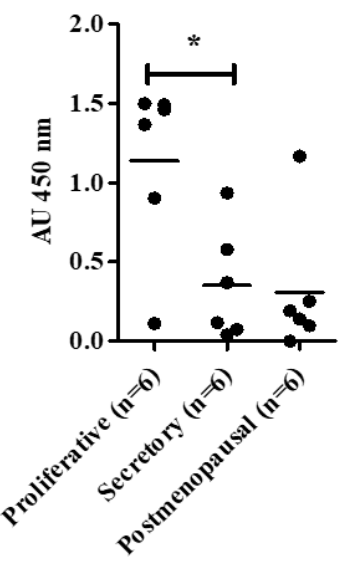
Figure 5. Telomerase activity (TA) in human endometrial tissue samples. TA was measured using Telomerase Repeat Amplification Protocol (TRAP) assay. Proliferative (PP) ( n = 6), secretory phase (SP) ( n = 6) and postmenopausal (PM) endometrial samples ( n = 6). * p < 0.05.